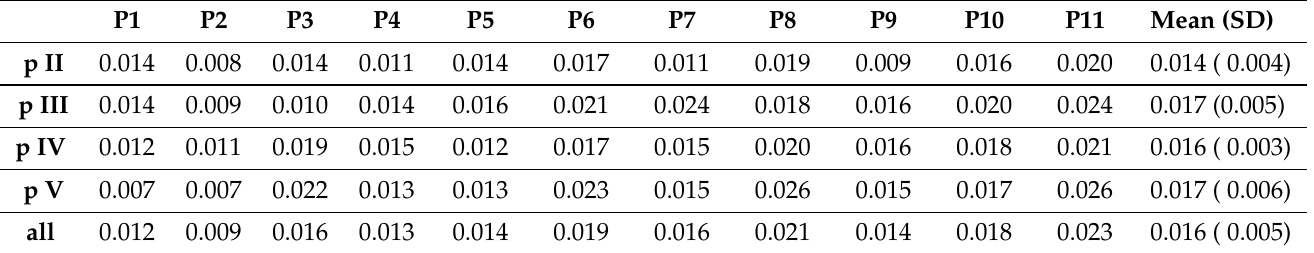
Figure 4. Individual mean changes for participants 1 (red) and 6 (purple) for all bacteria in phase V. Black line: population mean. The bacteria in each phase are in descending order according to their mean value. Table 1. Estimates of τ for participants P1 – P11 and mean values of all participants for phases p II – V